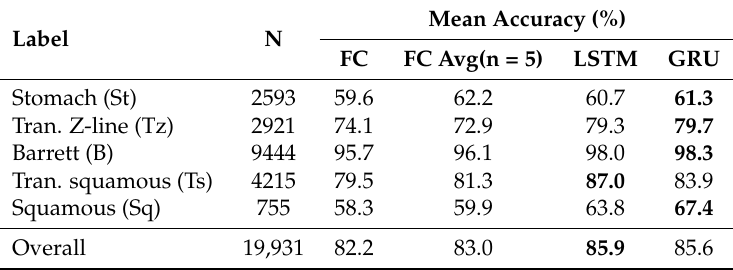
Table 2. Mean accuracy per tissue class, and for various architecture configurations. Scores are averaged over all patient cases. The mean label accuracy is in correspondence with the label classification from Table 1. The classifiers reported are Fully Connected classifier, Fully Connected Averaged(n = 5), Long Short-Term Memory classifier, and Gated Recurrent Unit